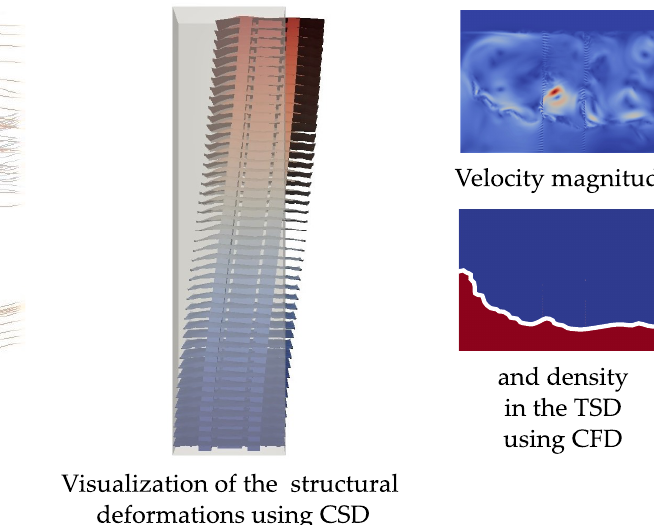
Figure 12. Representative visual results using a computational workflow.